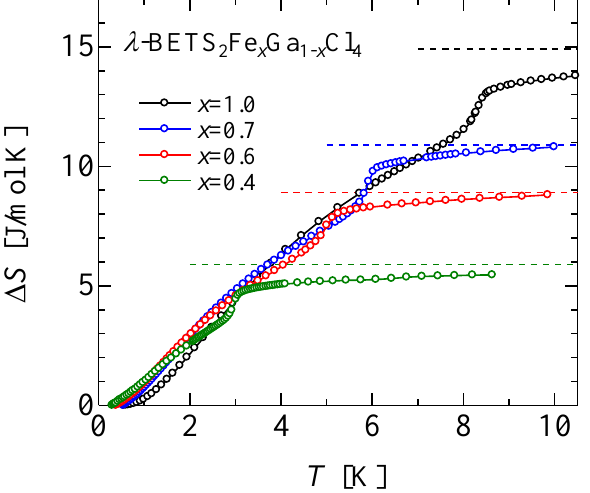
Figure 7. Temperature dependencies of spin entropy of λ-BETS from Δ C . The dashed lines show the degrees of freedom for 3 d spins for values of xR